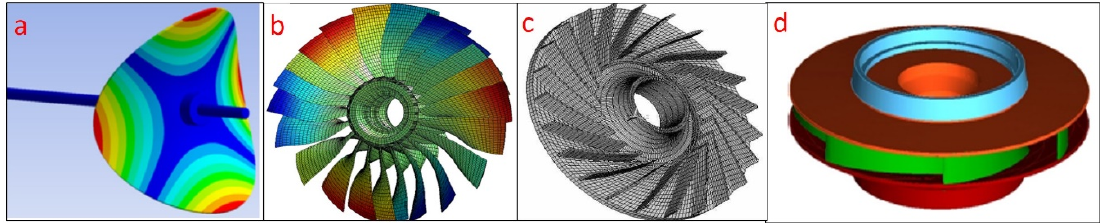
Figure 1. Examples of rotating structures involving disks: ( a ) Simple Disk structure [3], ( b ) Bladed disk structure [4], ( c ) Disk-blade assembly [5], and ( d ) Disk-blades-disk assembly [6].